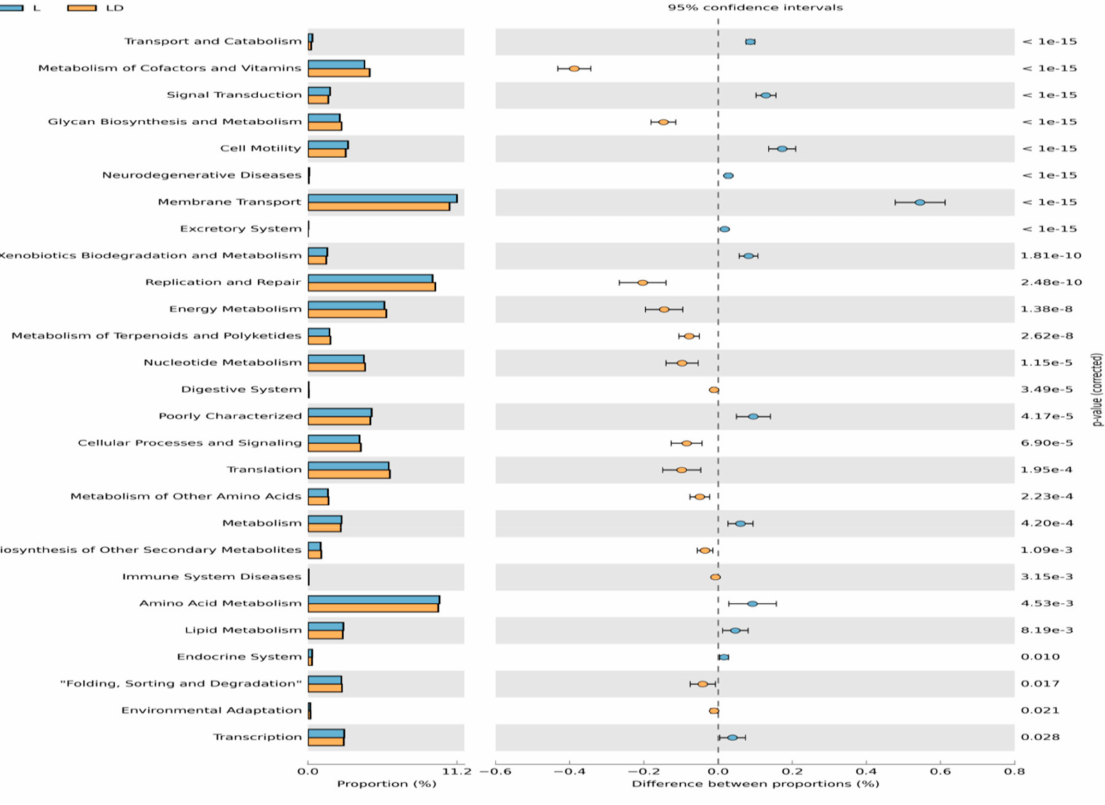
Figure 6. Mean proportion and their di ff erences in predicted functional metagenomes of the cecum microbiota. Blue color indicates stage L and yellow indicates stage